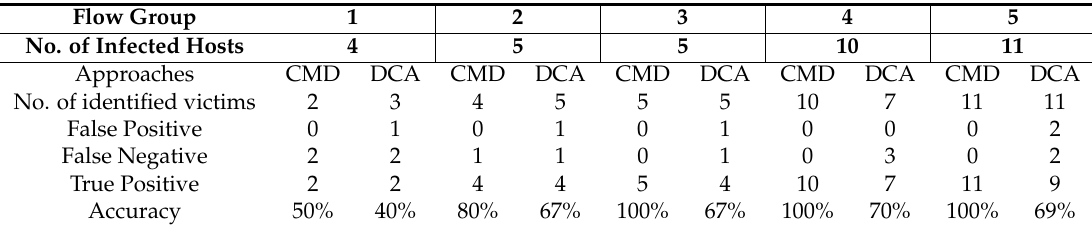
Table 6. Evaluated comparison of the Cascading Motif Discovery-based method and Destination-source Correlation Algorithm for each flow group under the UDP worm simulated experiment. Flow Group